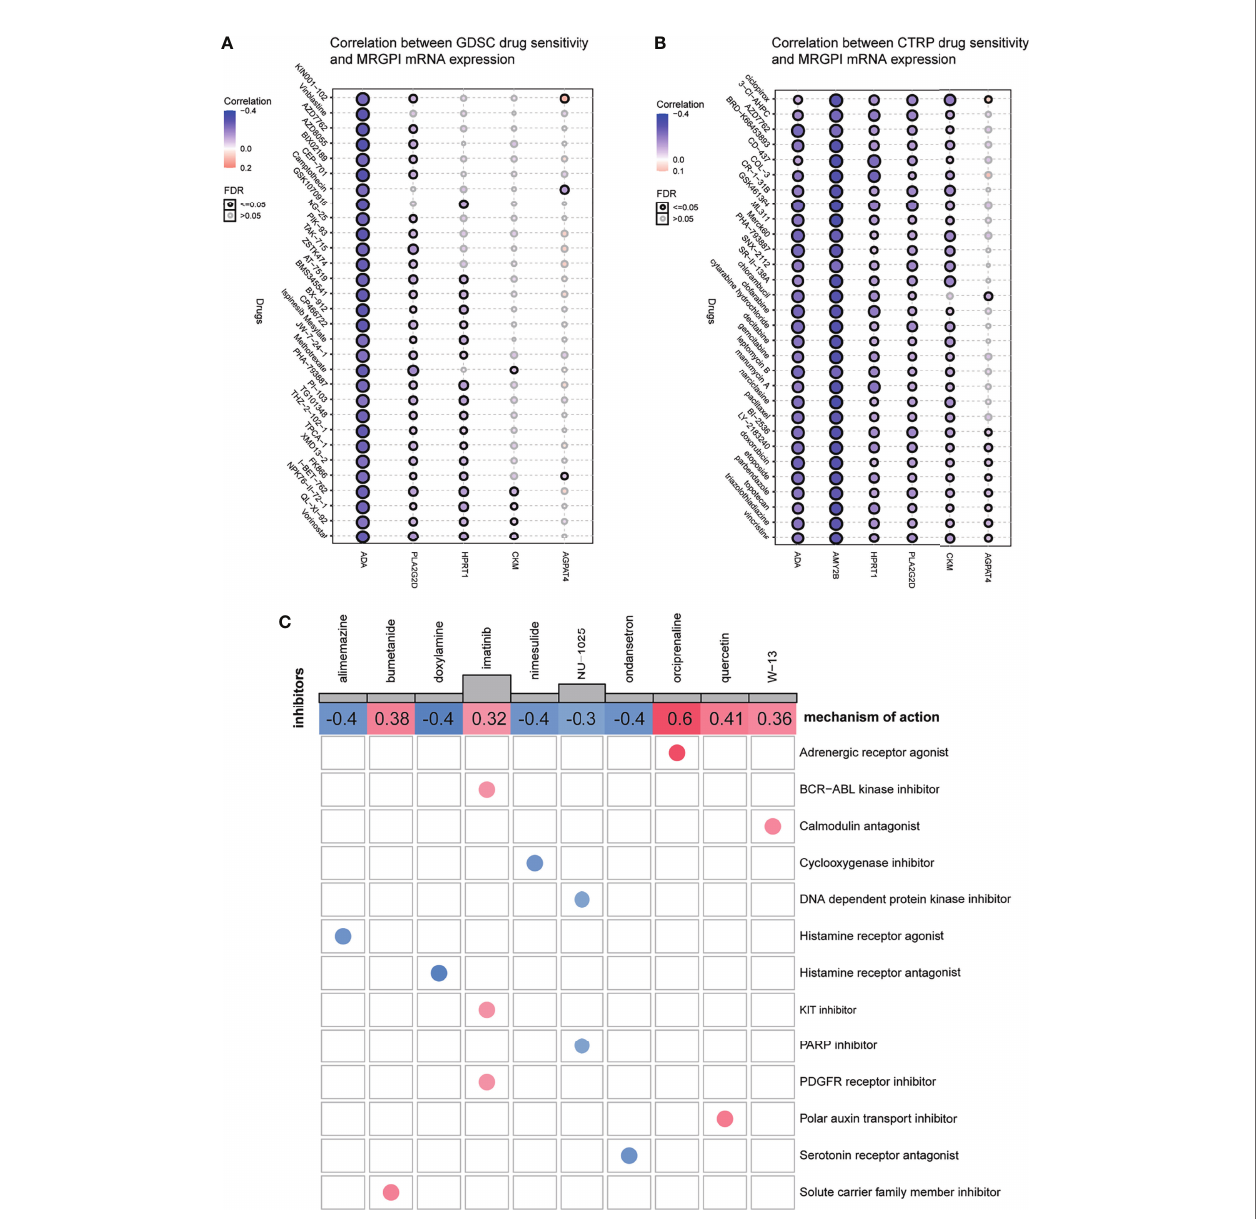
FIGURE 6 | Drug sensitivity analysis and potential inhibitors targeting the MRGPI subgroups. (A) Correlation between GDSC drug sensitivity and the MRGPI gene expression. (B) Correlation between CTRP drug sensitivity and the MRGPI gene expression. (C) cMAP analysis in the different MRGPI subgroups. MRGPI, metabolism-related gene prognostic index; GDSC, Genomics of Drug Sensitivity in Cancer; CTRP, Cancer Therapeutics Response Portal; cMAP, Connectivity